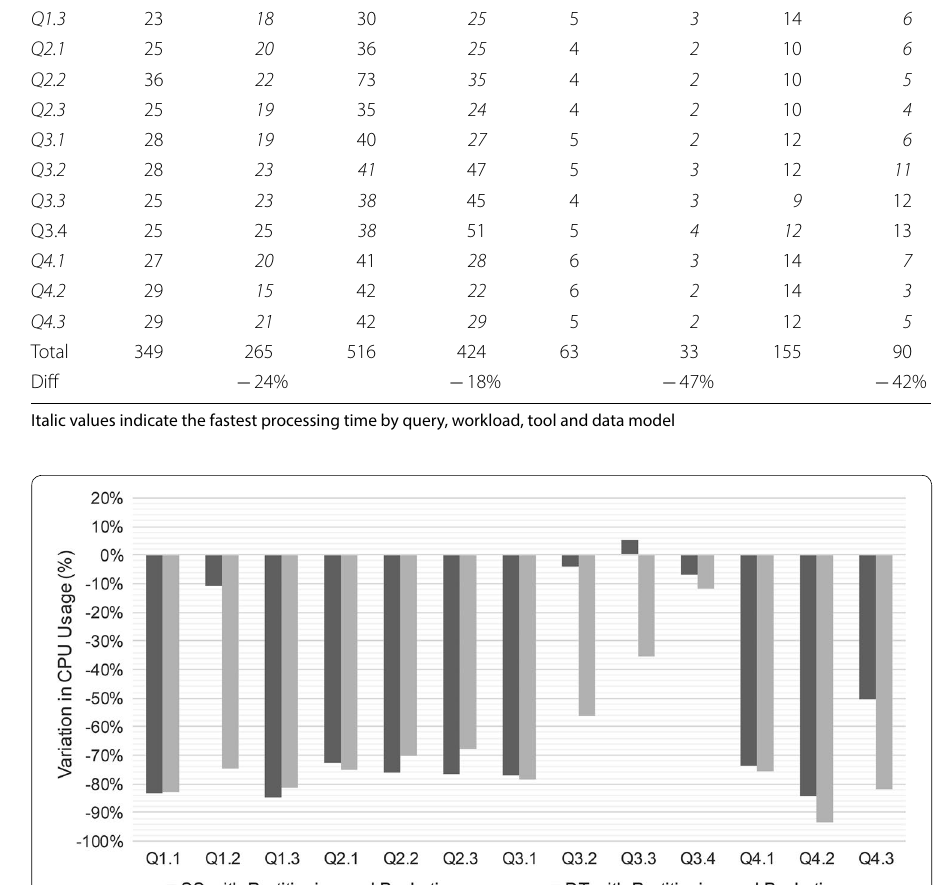
were used to partition the table. Only Q1.2 and Q3.4 do not include any of them in their